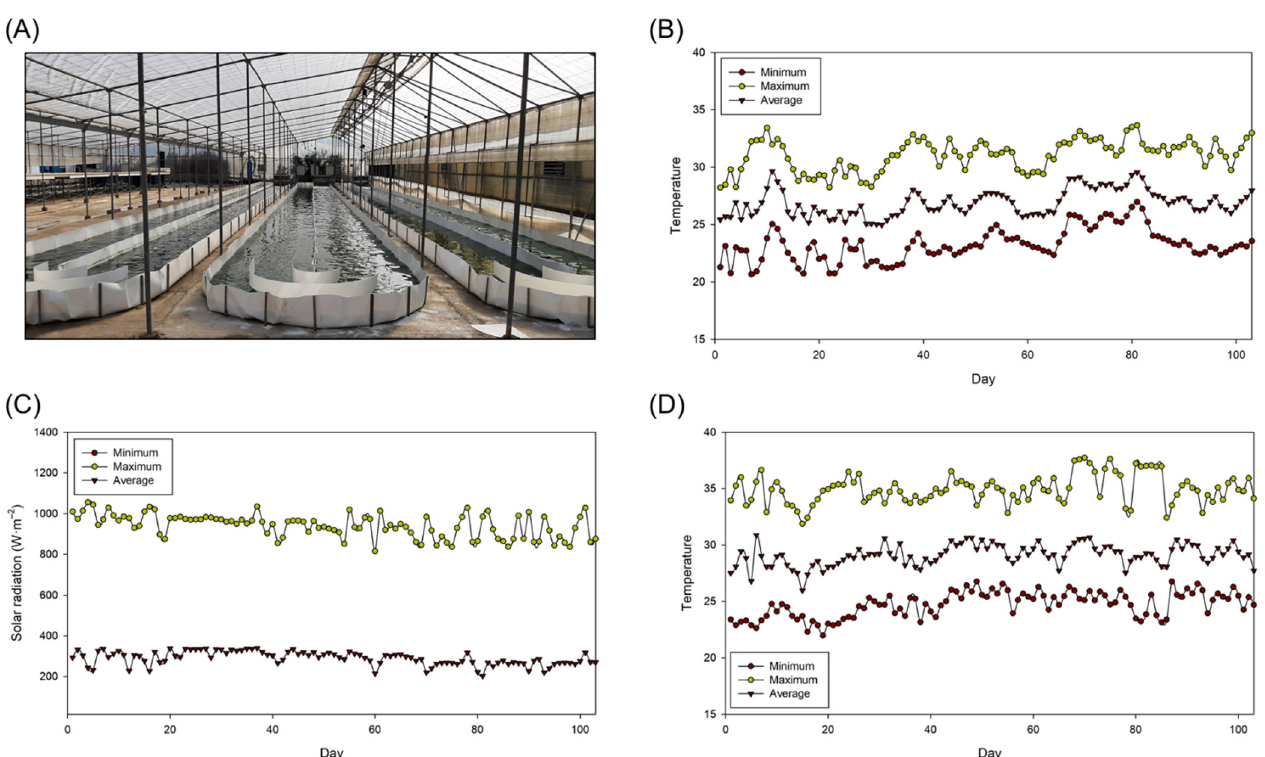
Figure 1. ( A ) Photobioreactors used, ( B ) temperature inside the greenhouse, ( C ) solar radiation that reached the culture, and ( D ) temperature of the culture during biomass production. Maximum and minimum values refer to the maximum and minimum temperature or solar radiation values measured every day. The average temperature values refer the average temperature during the 24 h and the average solar radiation values refer to the average irradiance during the illuminated period.